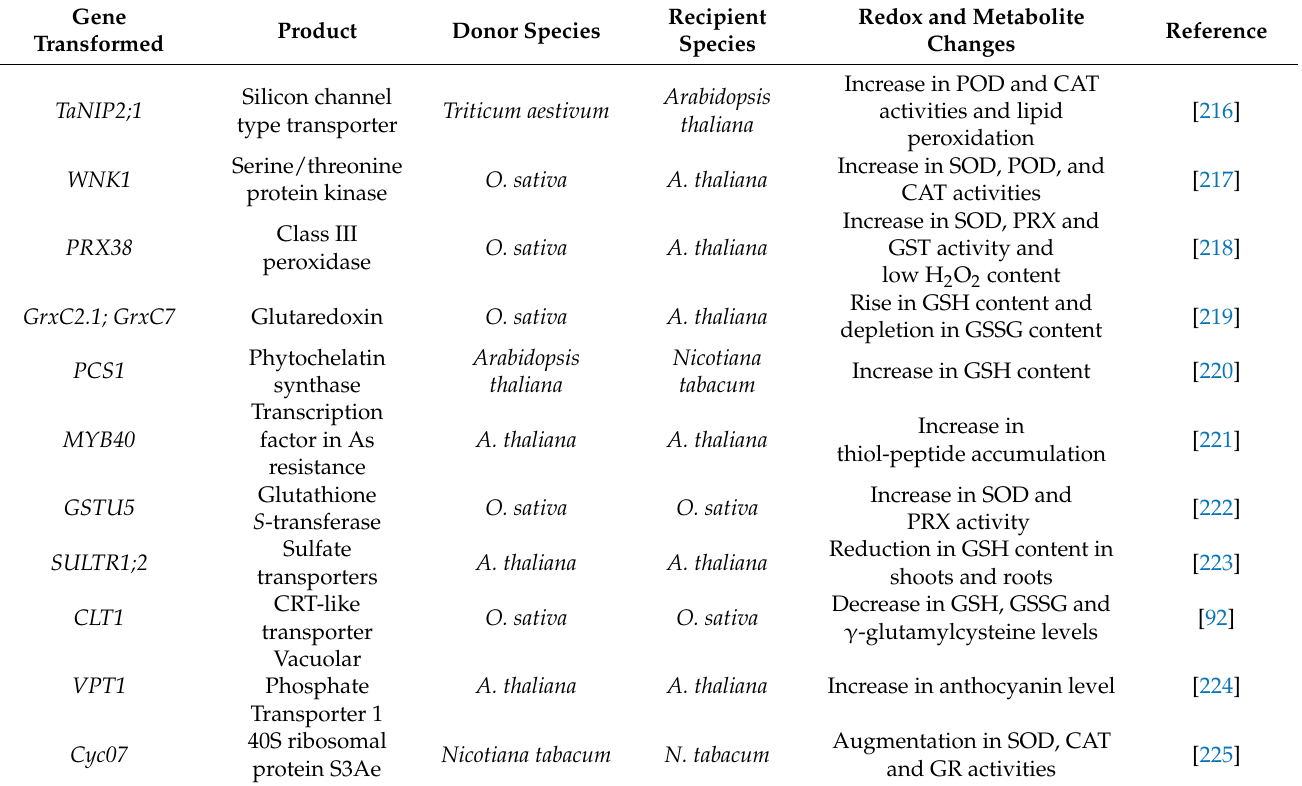
Table 5. Genetic engineering approaches for As tolerance and redox and metabolite